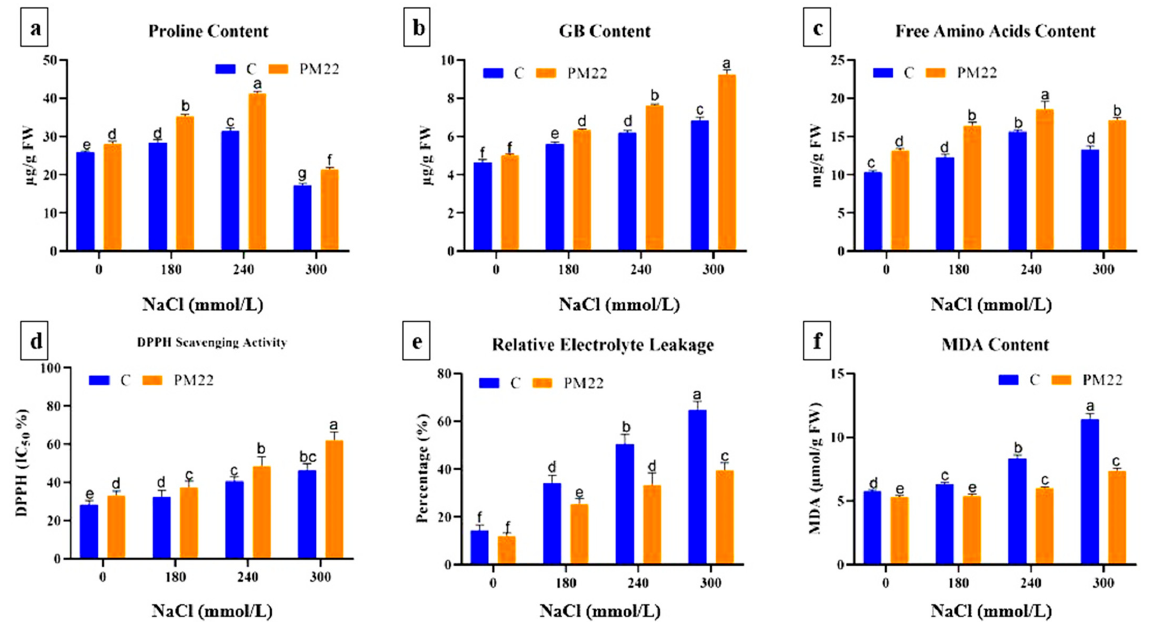
Figure 4. Impacts of various treatments on proline, glycine betaine, free amino acid contents, and oxidative stress indicators of PM22-inoculated maize at different salt stress levels (0, 180, 240, and 300 mM). Soil containing non-inoculated seeds and soil with seeds inoculated with B. Safensis (PM22) were the two treatments. The values are the averages of three triplicates with standard errors of the mean. Different alphabets have significantly different values ( p = 0.05) from each other, according to Tukey’s least significant difference test.